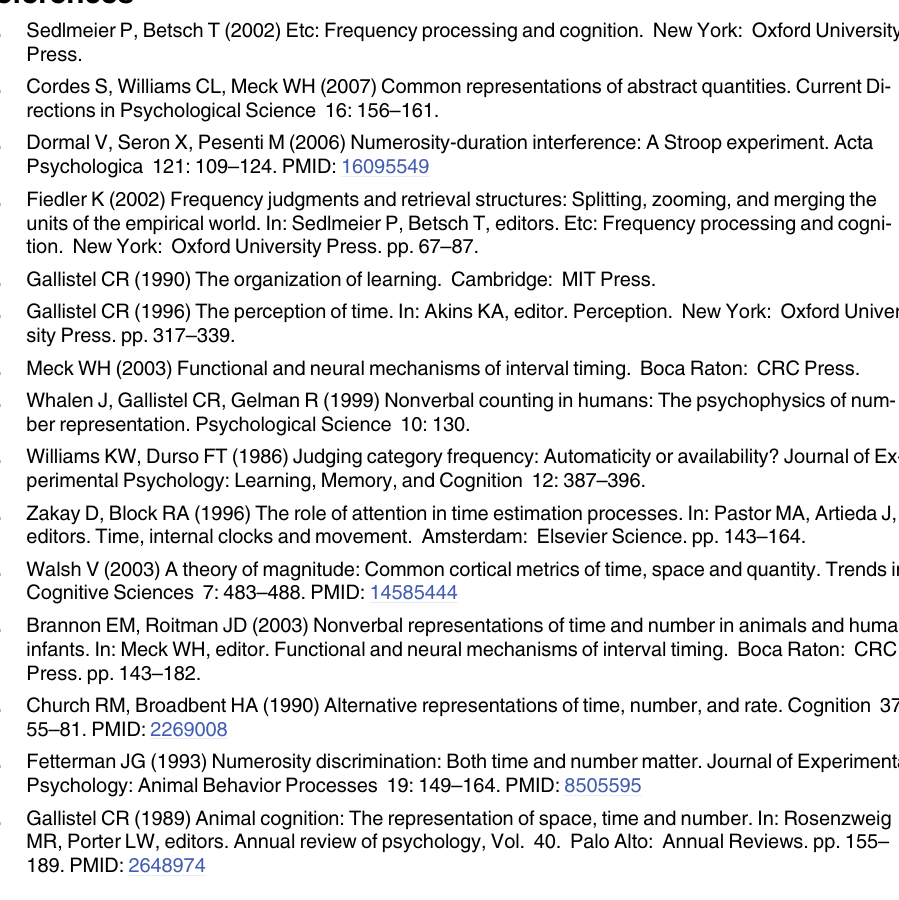
S2 Table. Means of frequency and duration judgments for names, low-emotion pictures and high-emotion pictures under low and high physical